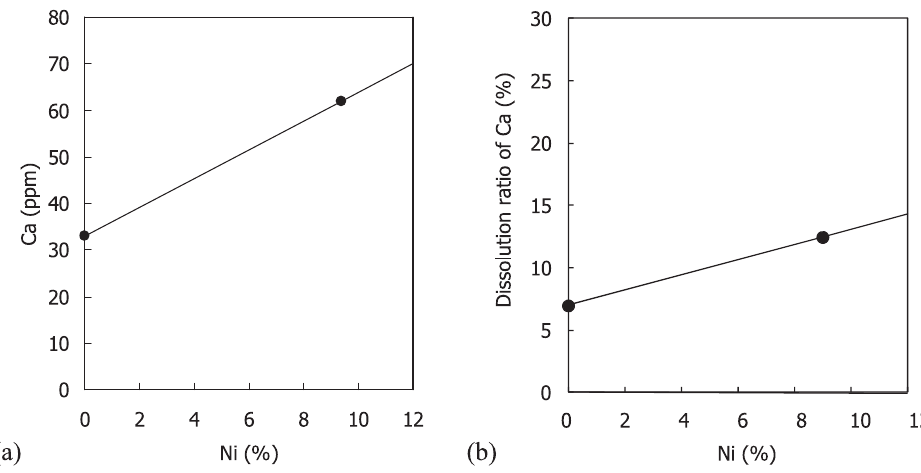
Fig. 4: Calcium concentrations (a) and the dissolution ratios (b) after RH-degassing process in plant